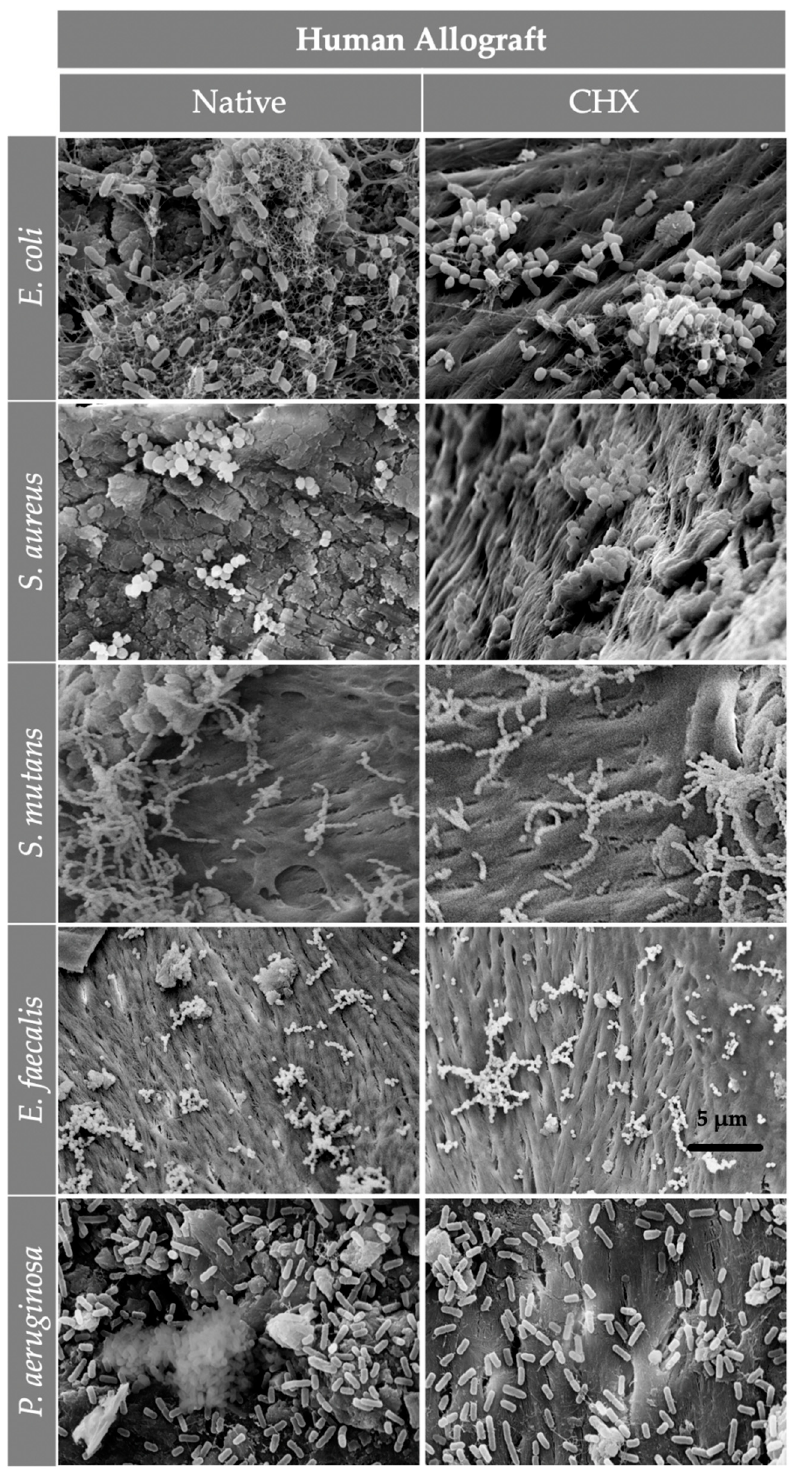
Figure 5. The SEM assessment for all bone graft materials [( a ) Tutobone ® , ( b ) HA-Endobon ® and ( c ) Human Spongiosa] and bacteria strains in presence or absence of CHX solution 0.2% in a magnification of ×5000 is depicted. The micrograph shows a successful adhesion of the microorganisms on the bone scaffold with formation of bacterial clusters or chains on the planar surfaces as well as in the topographic niches. The bar represents 5 µm.